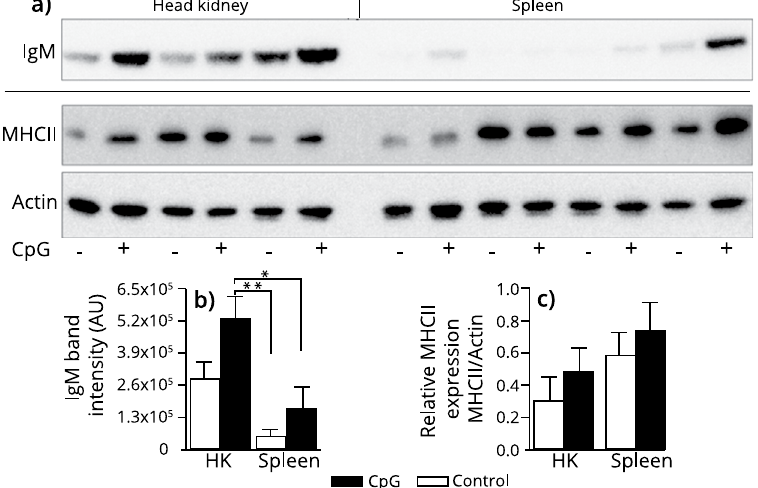
Figure 6. Protein level analysis of IgM and MHCII expression by Western blot. MACS purified IgM + B cells from head kidney (HK) and spleen were treated with CpG ( + ; 2 µ M) or left untreated ( − ) for 72 hours before harvest of supernatants and cell lysates. Figures present results from two independent experiments. ( a ) Representative Western blot analysis showing IgM secretion in supernatants (upper panel), and MHCII expression in cell lysates (middle panel). An anti-actin Ab was applied as loading control (lower panel). MHCII and actin were run on the same gel; after MHCII detection, the gel was washed and reprobed with the anti-actin Ab. Bar graphs showing the mean band intensity (AU) of ( b ) secreted IgM and ( c ) MHCII relative expression in HK and spleen B cells (n = 6). Significantly higher IgM secretion is indicated by * where * p < 0.05 and ** p < 0.01. The original full blot images can be found in Supplemental Fig. S5.